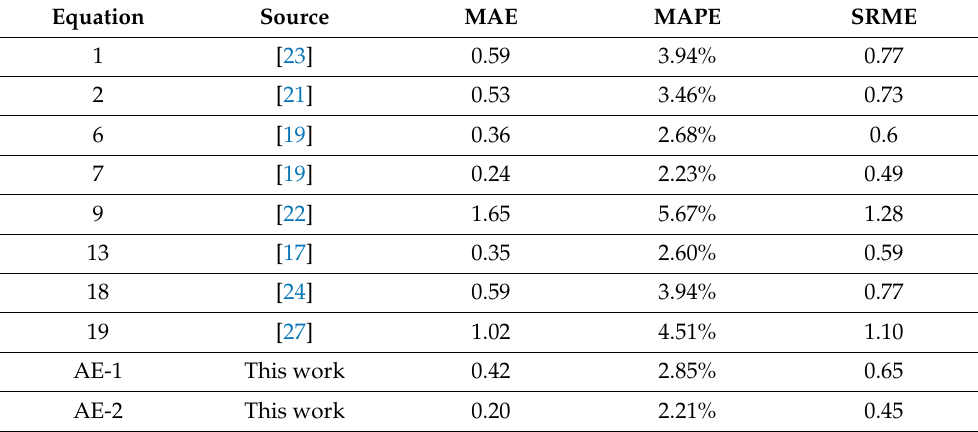
Table 12. Error table for equations based on ultimate